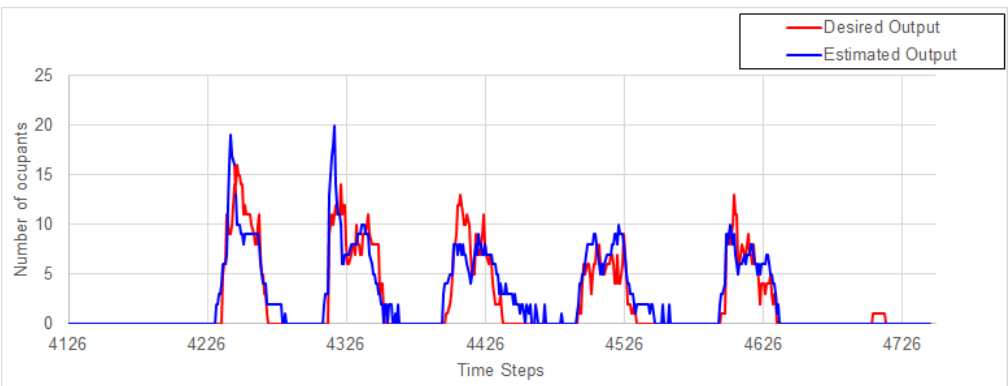
Figure 14. Prediction results of the 8th week, according to the indoor data set: T in , RH in , CO 2 .